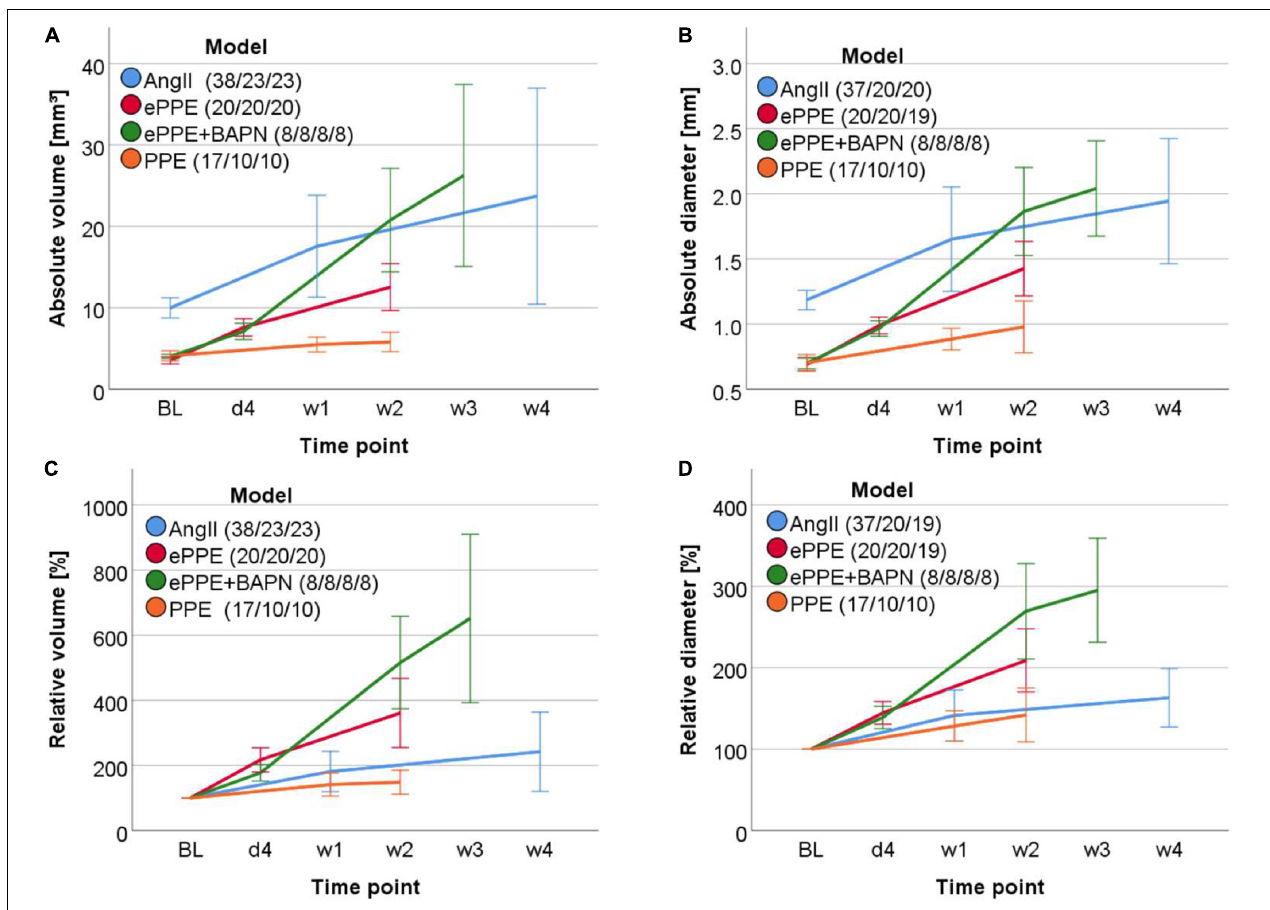
FIGURE 3 | Time course of aorta expansion in four AAA mouse models. (A) Volume (mm 3 ) over a 12 mm aortic stretch, (B) maximum aortic diameter (mm), (C) relative volume (%) in relation to baseline and (D) relative diameter (% of baseline) were measured by 3D US over time and are shown by line graphs. Time points included baseline (BL), day 4 after AAA induction (d4), week 1 (w1): days 6–8, w2: days 13–14, w3: day 21, w4: d27. Average measurements of two independent observers were applied. Variation between mice is illustrated by mean value ± standard deviation for each model and time